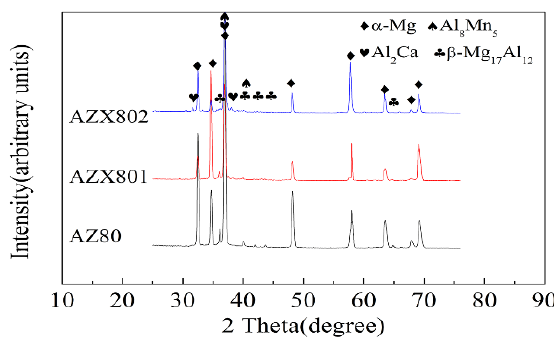
Figure 4. XRD patterns of as-cast AZ80, AZX801 and AZX802 alloys. XRD patterns of as-cast alloys show the phase composition.